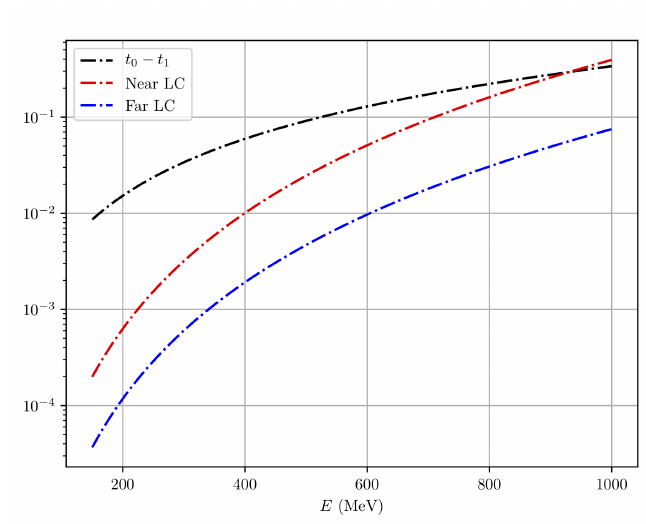
Figure 6: Comparison between the moduli of the near and far left cut pieces of − t Eq. (53) and t for the IJ = 11 0 1